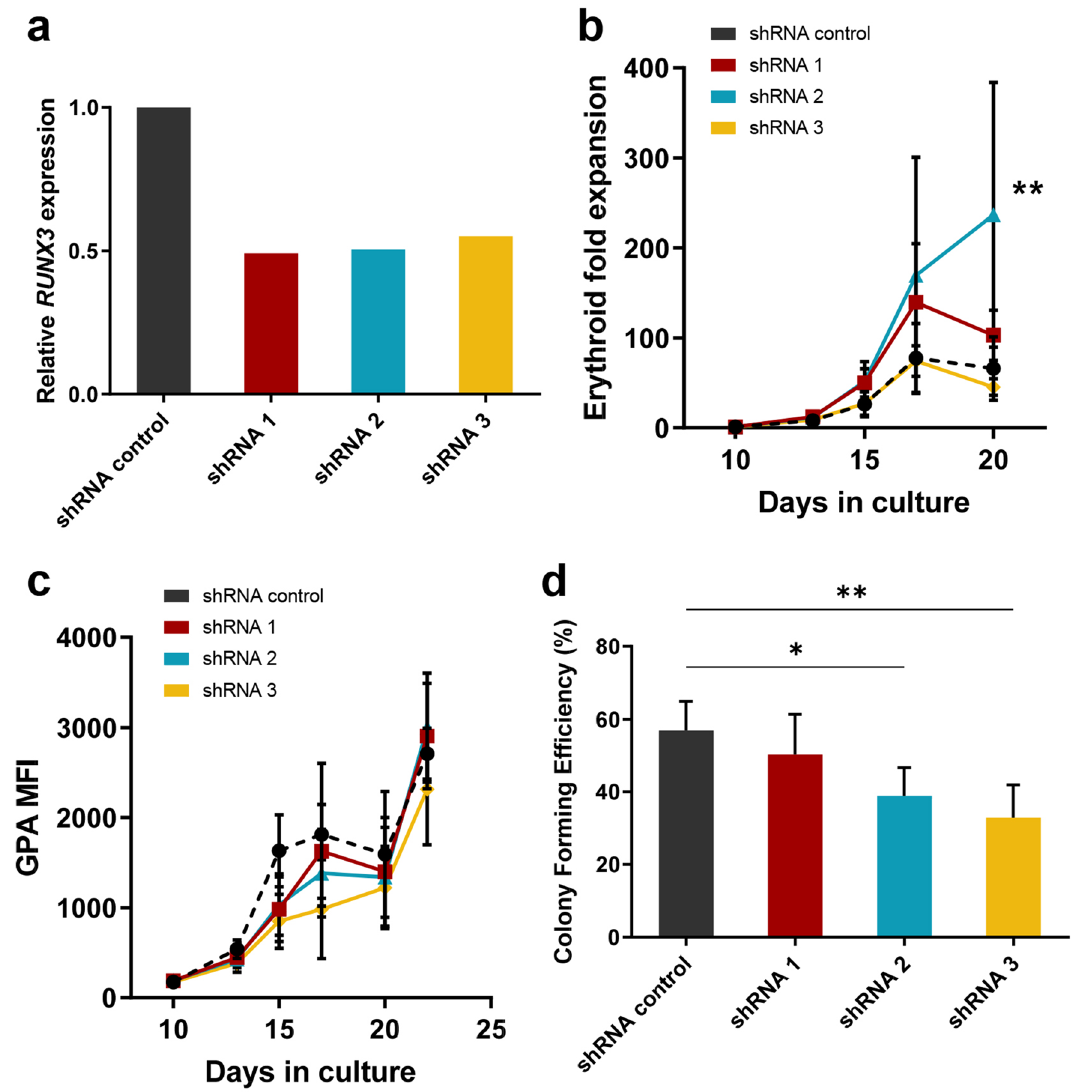
Figure 6. Knockdown of RUNX3 impairs erythroid colony formation efficiency, but not erythroid growth and development in bulk liquid culture. ( a ) qRT-PCR analysis of RUNX3 mRNA levels in shRNA control and RUNX3 KD HSPC sorted for GFP positivity on day 3 of culture (n = 1). GAPDH was used as endogenous control. Relative expression calculated using the Comparative CT (ΔΔC T ) method. ( b ) Cumulative expansion of erythroid progenitors in shRNA control and RUNX3 KD cultures during the EPO dependent phase of growth. HSPC were initially cultured with IL-3, IL-6 and SCF for 10 days followed by addition of EPO at day 10. Data indicate mean ± 1SD (n ≥ 3). Significant differences were analysed by one-way ANOVA using Tukey’s multiple comparisons test, ** p < 0.01. ( c ) Summary data showing GPA expression (MFI) in GFP + CD13 low CD36 high cells over time. Data indicate mean ± 1SD (n ≥ 3). ( d ) Erythroid colony forming efficiency of shRNA control and RUNX3 KD cultures after 7 days of growth in liquid culture. Data indicate mean ± 1SD (n ≥ 4). Significant differences were analysed by one-way ANOVA using Tukey’s multiple comparisons test, * p < 0.05, ** p <